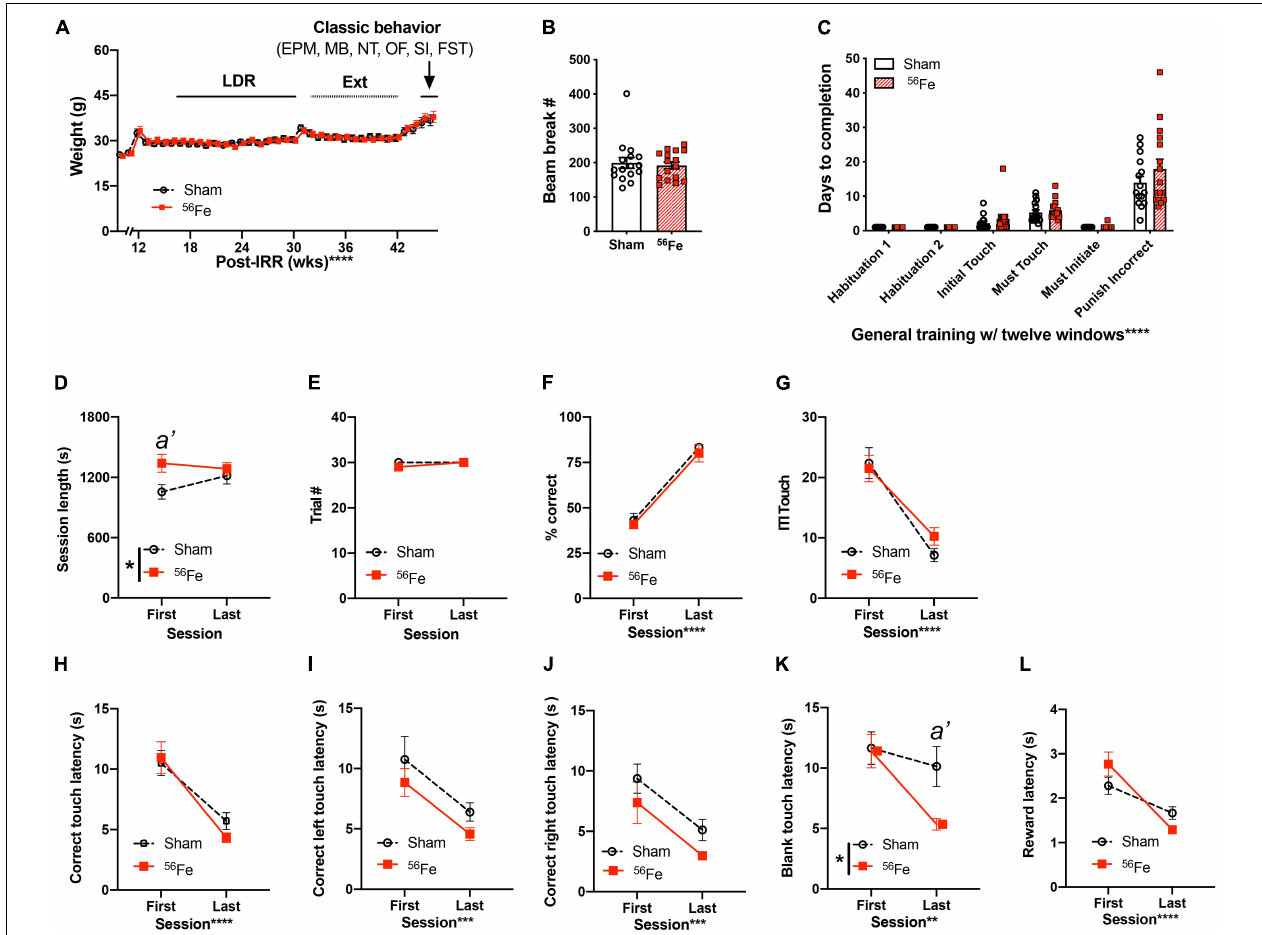
FIGURE 2 | Weights, locomotion, and general touchscreen training learning are generally unaffected in 6-mon old female mice exposed to whole-body 56 Fe IRR compared to Sham. (A) No gross weekly weight difference was detected between Sham or 56 Fe mice during touchscreen testing. (B) Beam breaks measured in the novel TS operant chambers in Habituation 1 revealed no gross baseline difference in locomotion after exposure to Sham or 56 Fe IRR. (C) Sham and 56 Fe IRR groups performed similarly in each of the first six steps of general touchscreen training with twelve windows: Habituation 1 and 2, Initial Touch, Must Touch, Must Initiate, and Punish Incorrect. (D–L) During the Punish Incorrect stage of general TS training, 56 Fe IRR female mice had a longer first, but not last, training session vs. Sham mice (D) . However, Sham and 56 Fe IRR mice did not differ in the number of completed trials (E) ,% correct (F) , total ITI touches (G) , correct touch latency (H) , and correct left or right touch latency (I,J) . (K) 56 Fe IRR female mice were ∼ 5 s faster vs. Sham mice to touch a blank window in the final session of testing. Aside from these differences, IRR and Sham mice had similar reward collection latency (L). Error bars depict mean ± SEM. Mixed-effects analysis was used in panel (A) main effects: Time F 36 , 1067 = 66.05, p < 0.0001 and Treatment F 1 , 30 = 0.02450, p = 0.8767; interaction: Treatment × Time F 36 , 1067 = 1.586, p = 0.0161, post hoc : all p > 0.05. Unpaired t -test was used in panel (B) ; p = 0.6979. Two-way RM ANOVA was used in panels (C–L) : main effect * p < 0.05; ** p < 0.01; *** p < 0.001; **** p < 0.0001, Bonferroni’s post hoc analysis a’ p < 0.05. In panel (D) , main effects: Session F 1 , 29 = 0.5688, p = 0.4568 and Treatment F 1 , 29 = 4.532, p = 0.0419 ( post hoc : a’ p = 0.0228, in Sham vs. 56 Fe, ω p 2 = 0.07) and interaction: Session × Treatment F 1 , 29 = 2.345, p = 0.1365. In panel (K) , main effects: